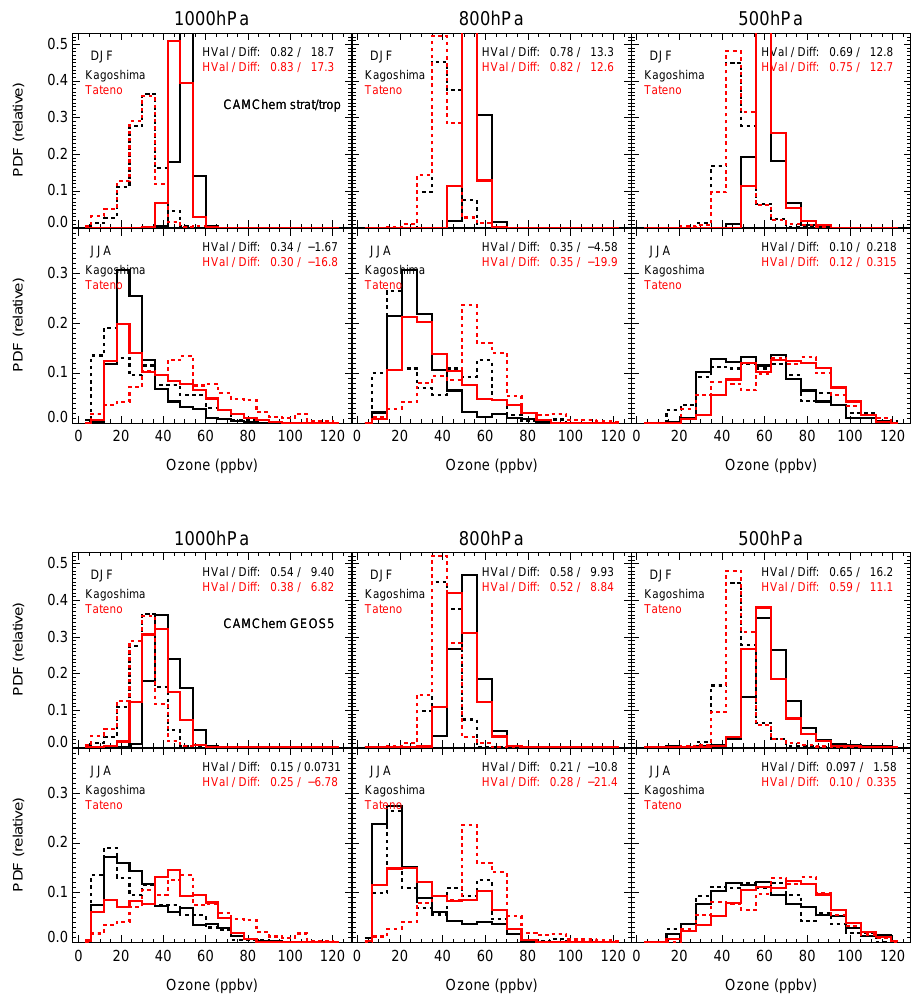
Fig. 15. Top panel: PDFs of ozone distributions at 1000hPa (left), 800hPa (middle), and 500hPa (right) for DJF (first and third row) and JJA (second and fourth row) from observations for two ozone stations in Japan. Model results are shown in solid lines and observations in dashed lines. Results from CAMChem strat/trop are shown in the first and second row, CAMChem GEOS5 results are shown in the third and fourths row. Information about the Hellinger distance and median difference between models and observations is given on the top right in each